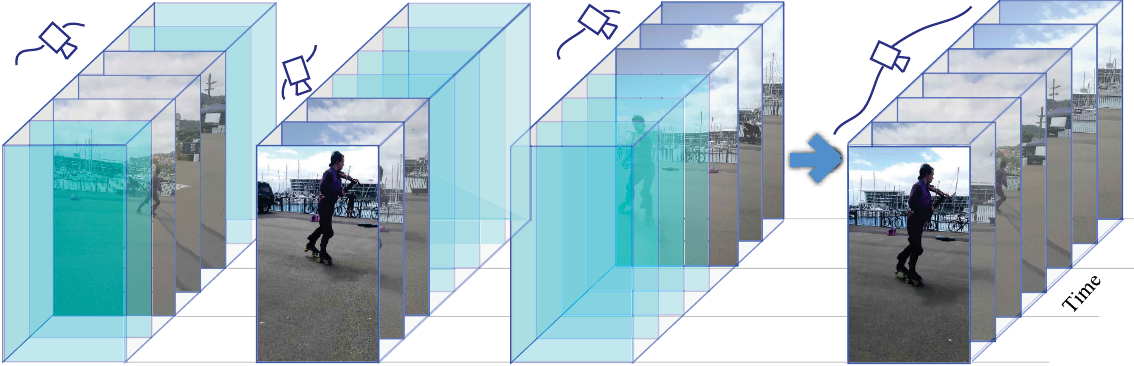
Fig. 1 We propose a method to synthesize a smooth video sequence from multiple videos captured by hand-held cameras. The captured footage may contain dynamic foreground objects such as the human performer shown